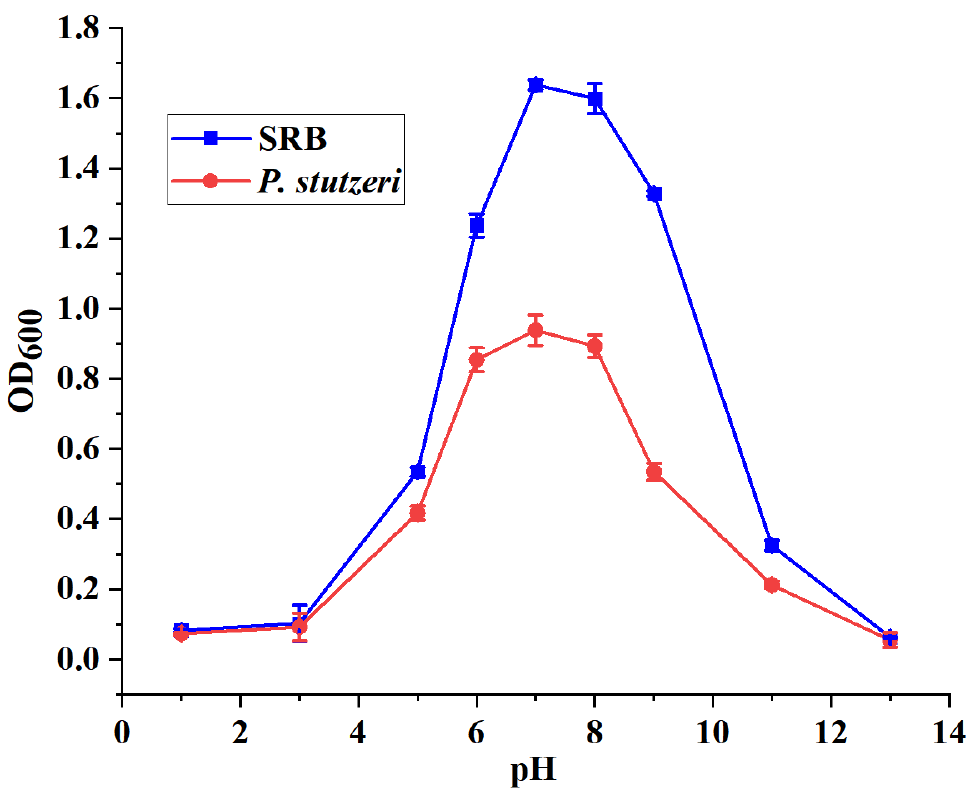
Figure 4. Effect of pH on strain growth.